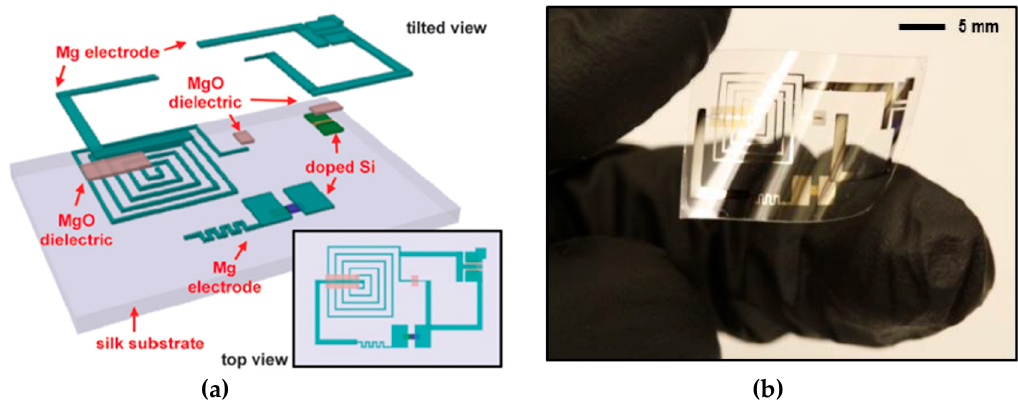
Figure 7. ( a ) Schematic of fabrication of process of transient electronics by using stencil lithography. Mg and MgO were patterned on silk substrate sequentially with stencil lithography. From [73]. Reprinted with permission from AAAS. ( b ) Image of a flexible transient electronic device patterned by using polyimide based stencil lithography. From [73]. Reprinted with permission from AAAS.